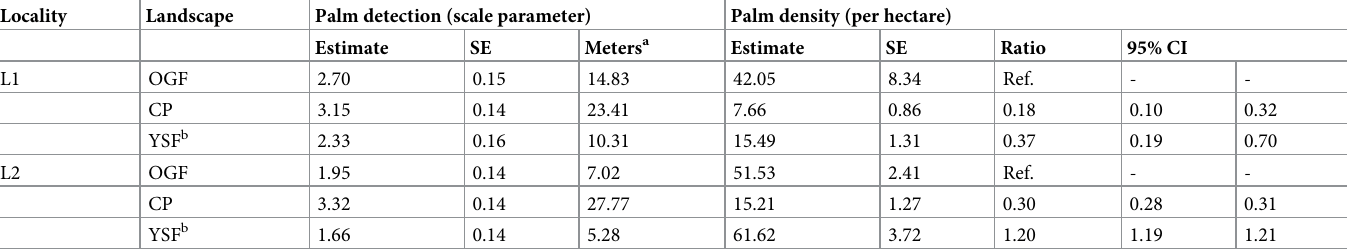
OGF, old-growth forest; CP, cattle pasture; YSF, young secondary forest; SE, standard error; CI, confidence interval; Ref., reference class (palm density taken to be 1.0). a Exponentiated scale parameter; the lower the scale parameter value, the faster the decline of detection probabilities with increasing distance between palms and the transect’s central trail. b Visual inspection of Landsat satellite imagery (https://earthexplorer.usgs.gov/) suggested that, at the time of sampling, secondary forest had been growing for ~4–5 y in L1 and for ~7–10 y in